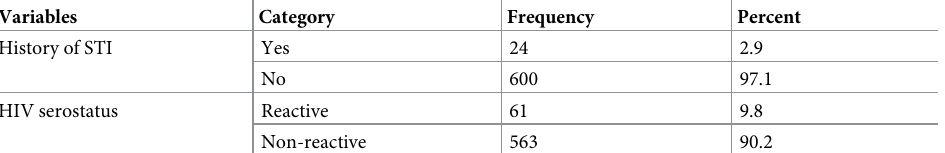
Table 2. Medical-related characteristics of pregnant women attending ANC in Jinka town public health facilities, Southern Ethiopia, 2020.